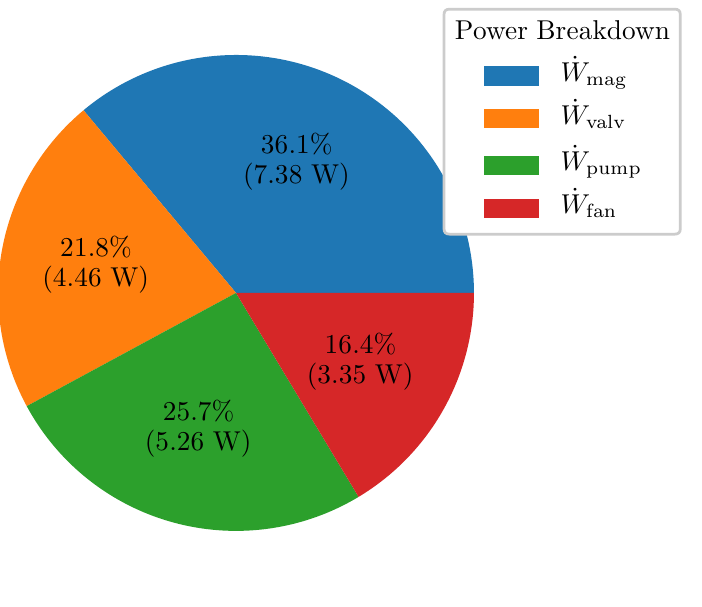
Figure 13. Average power breakdown for a wine cooler driven by a magnetic refrigeration system coupled with the heat exchanger/fan assembly Sample